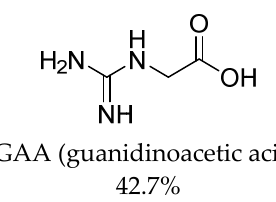
Figure 4. SLC6A6 ligand–thiomuscimol and impact of this GABA analogue on the taurine influx in APRE-19 cells. * Percent of inhibition of taurine uptake in 2 mM screening concentration [68].